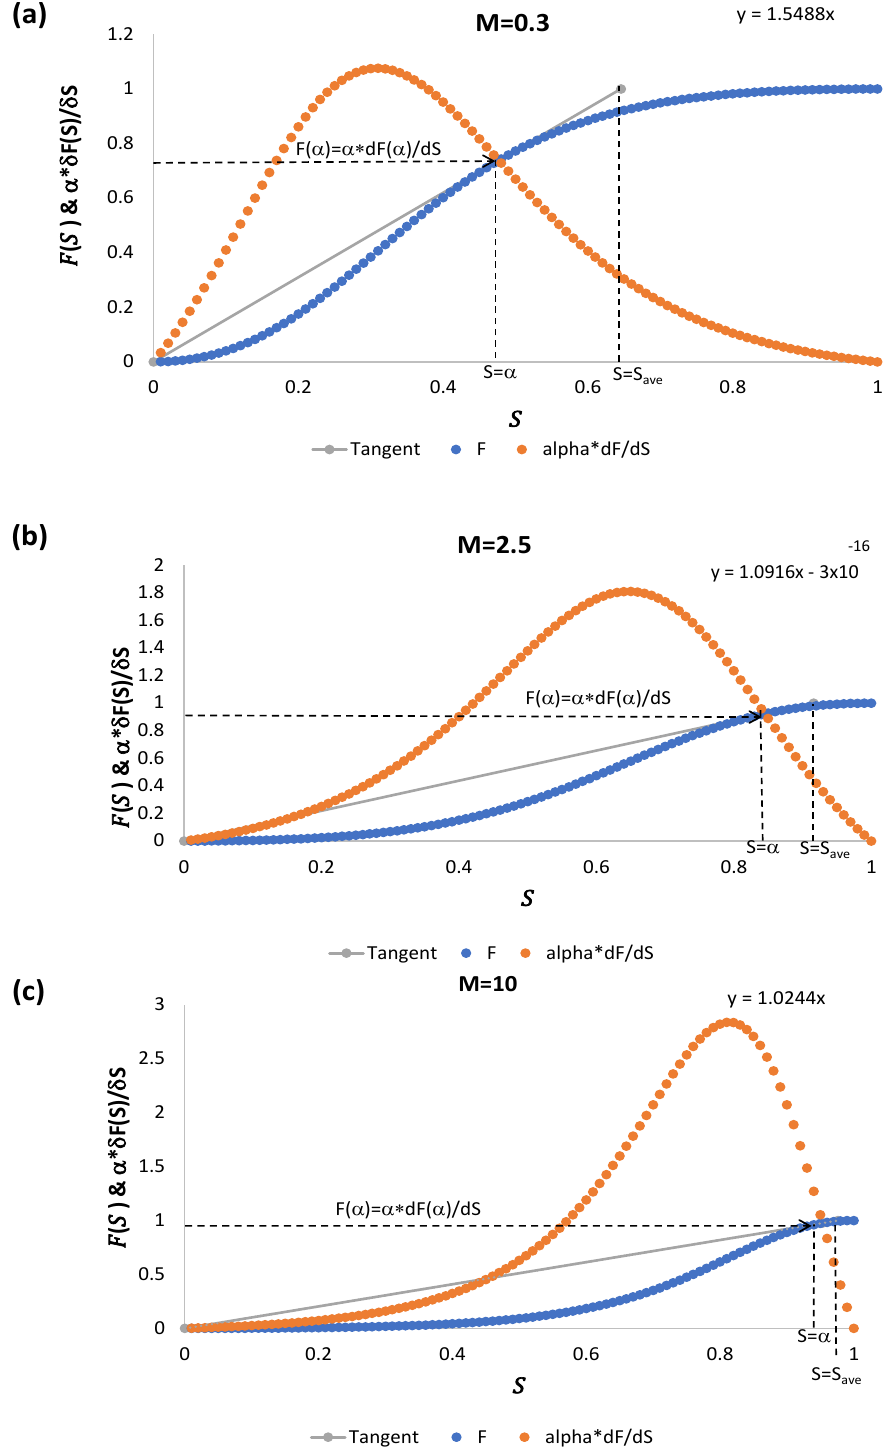
Figure 6. The function F ( S ) and its derivative as functions of the saturation S for three mobility ratios ( a ) M=0.3, ( b ) M=2.5, and ( c ) M=10. The tangent and point of intersection with abscise α are also